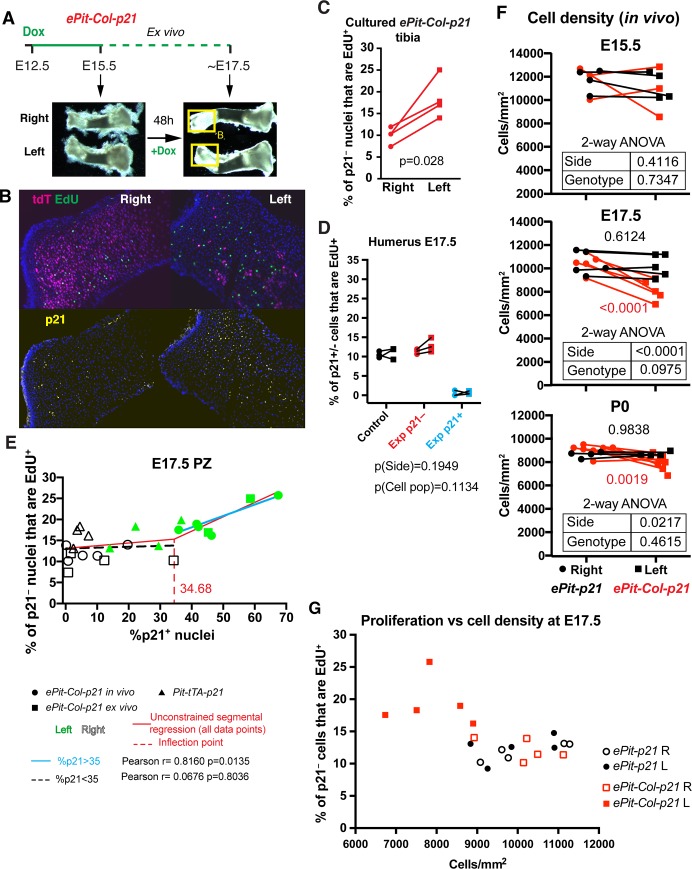
Compensatory proliferation is bone-intrinsic and takes place when chondrocyte density is lower than normal.(A) Summary of the ex vivo tibial culture experiment. The boxed regions correspond to the epiphyses shown in panel B. (B) Immunohistochemistry for the indicated molecules. (C) EdU quantification on distal PZ sections obtained from E15.5 ePit-Col-p21 tibiae cultured for 2 d. p-Value for 2-tailed paired t test comparing left and right proliferative ratios of p21− chondrocytes is shown (n = 4). The distal cartilage was quantified because the proximal one (bulkier) shows proliferation only in the periphery. (D) % of p21+ or p21− chondrocytes that have EdU+ nuclei in the PZ in the left and right proximal humerus of E17.5 ePit-p21 (Control, n = 3) and ePit-Col-p21 (Exp, n = 3) embryos. p21− cells from Control and Exp mice were compared by 2-way ANOVA with Side and Genotype as variables (p-values below graphs). (E) Correlation analysis between the extent of EdU incorporation in p21− cells and the amount of p21+ nuclei in left and right PZ of ePit-Col-p21 (n = 5 in vivo and n = 4 ex vivo) and Pit-tTA-p21 tibial cartilage (n = 4) at E17.5. The inflection point revealed by unconstrained segmental regression was rounded up and used as a dividing threshold for the 2 correlation analyses (colour-coded). Pearson correlation coefficients and 2-tailed p-values are shown. (F) Comparison of chondrocyte density in the PZ of left and right ePit-p21 and ePit-Col-p21 proximal tibial cartilage at E15.5 (n = 4 and n = 3), E17.5 (n = 5 and n = 5) and P0 (n = 4 and 7) and analysed by 2-way ANOVA for Genotype and Side (p-values shown in the embedded tables). When p < 0.05 for these variables, colour-coded p-values for Sidak’s post hoc tests are shown. (G) EdU incorporation in p21− chondrocytes of left and right PZ from E17.5 ePit-p21 and ePit-Col-p21 embryos (n = 5 each), plotted against cell density in the PZ. Note the sharp change in proliferation beyond 9,000 cells/mm2. For (C–G), see also S3 Data. Dox, doxycycline; E, embryonic day; EdU, 5-ethynyl-2’-deoxyuridine; Exp, Experimental; P, postnatal day; PZ, proliferative zone.